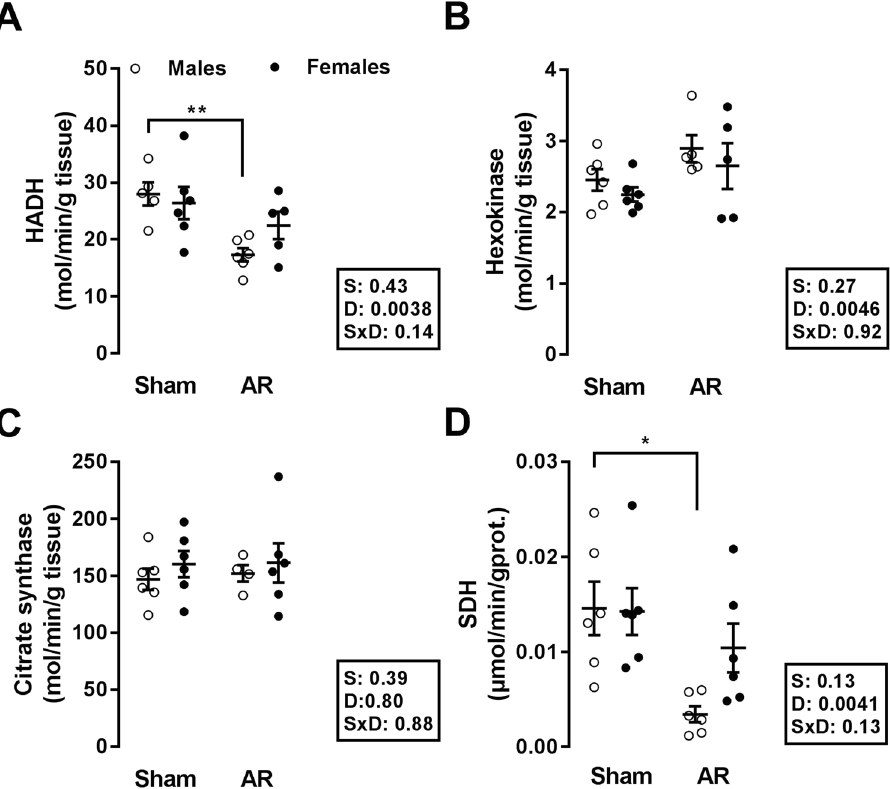
Figure 4. LV myocardial activity levels of enzymes implicated in fatty acid β -oxidation, glucose metabolism and mitochondrial energy production in male and female AR rats after 6 months. Hydroxyacyl-Coenzyme A dehydrogenase (HADH) ( A ), hexokinase (HK) ( B ), citrate synthase ( C ), and succinate dehydrogenase ( D ) enzymatic activities were measured in LV homogenates from 5–6 animals in each group as described in the Methods. The results are reported as the mean ± SEM. Probability values are from a 2-way ANOVA and Holm- Sedak post-testing. * p < 0.05 and ** p < 0.01 between indicated